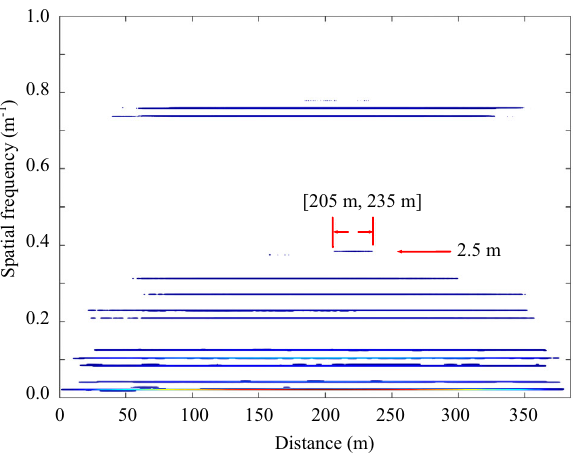
Fig. 17 Time–frequency analysis of the pantograph–catenary contact force under contact wire irregularity based